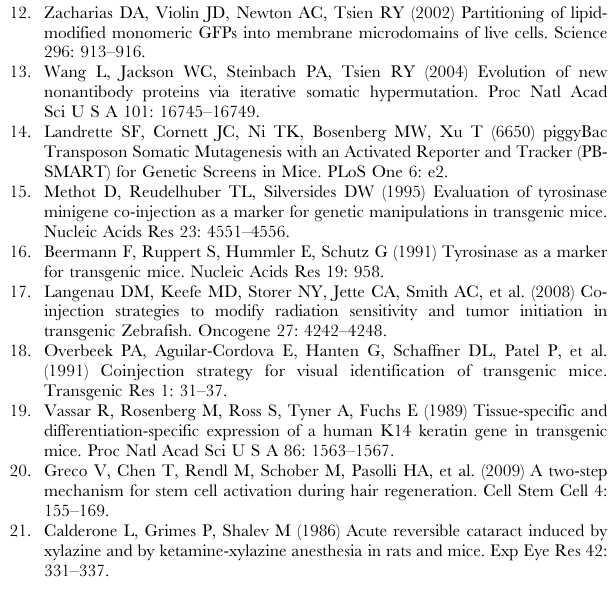
Figure S3 Anesthesia-induced acute cataracts affect fluorescent eye marker intensity. (A) Heterozygous and homozygous adult mice carrying tdTomato markers can be easily identified under a handheld flashlight. Mice imaged quickly have not developed cataracts. (B) tdTomato marker intensity increases following acute cataract formation (inset). Mice were imaged following ten minutes of